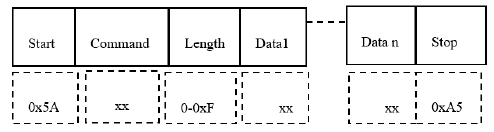
Figure 4. The structure of a control telegram.